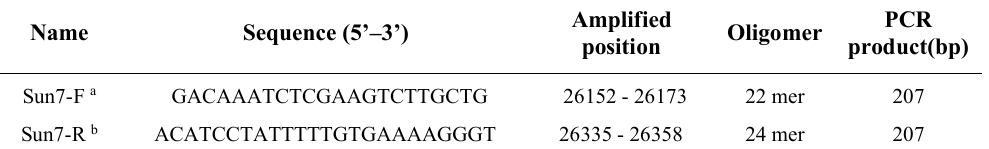
Table 2. Oligonucleotide primers used for exon7